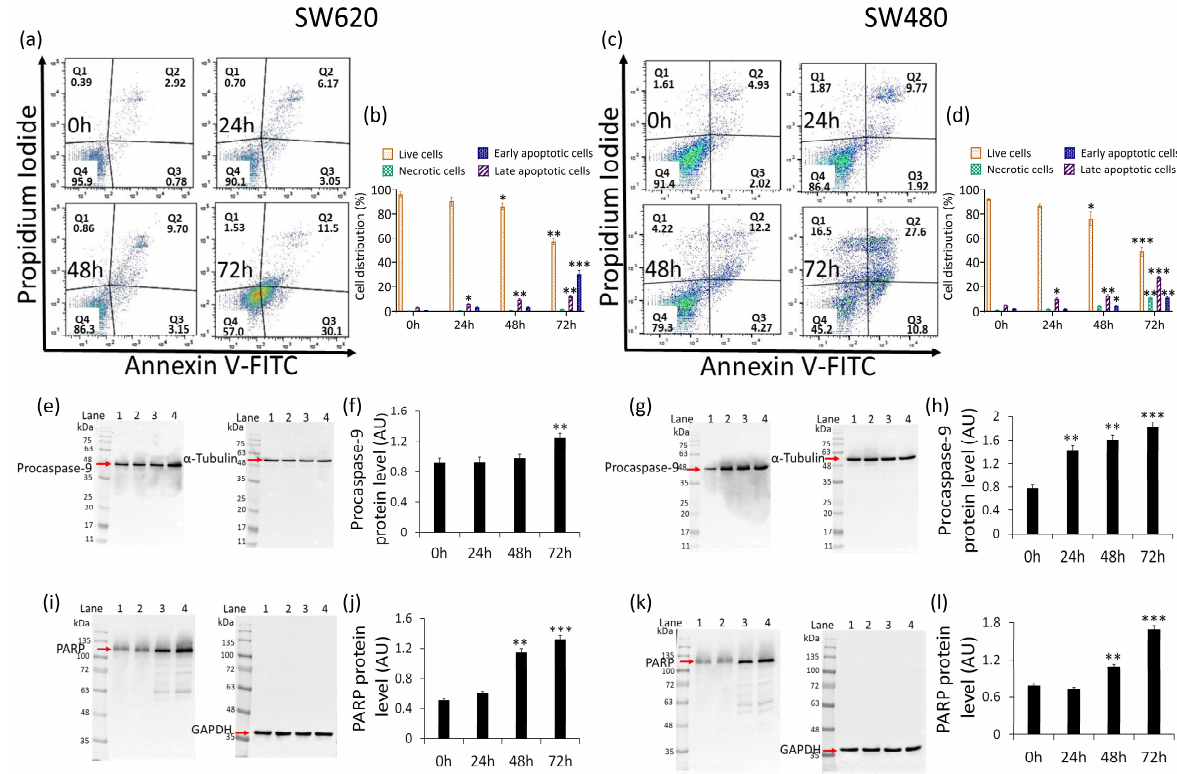
Figure 6. Effects of δ VB on colorectal adenocarcinoma cell death. Representative dot plots and analyses of annexin V-FITC and PI-stained ( a , b ) SW620 and ( c , d ) SW480 cells treated with 1.5 mM δ VB for 24, 48 and 72 h. Cell viability/death was assessed by flow cytometry where at least 10,000 events were acquired. Q1: necrotic cells; Q2: late apoptotic cells; Q3: early apoptotic cells; Q4: viable cells. Data are expressed as mean ± SD of n = 3 experiments. Representative full-length blots of Western blotting analysis of procaspase-9 ( e – h ) and PARP ( i – l ) in SW620 and SW480 cells. Lane 1 = 0 h; lane 2 = 24 h; lane 3 = 48 h; lane 4 = 72 h. Before lane 1, molecular weight markers (G266, Applied Biological Materials Inc., Richmond, BC, Canada). Protein expression was calculated, after normalization with internal control ( α -tubulin or GAPDH), with ImageJ software and results expressed as arbitrary units (AU). * p < 0.05 vs. Ctr; ** p < 0.01 vs. Ctr; *** p < 0.001 vs. Ctr.